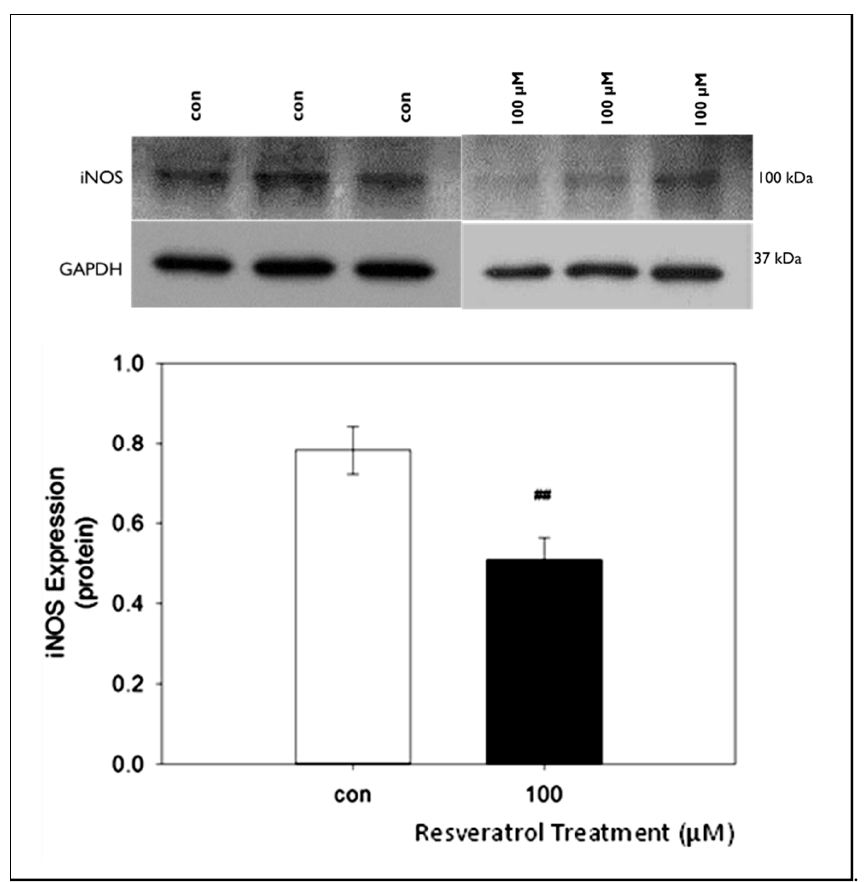
Figure 5. The e ff ects of 100 µ M resveratrol concentration on iNOS expression in GTM-3 cells. Figure Figure 5. The effects of 100 µM resveratrol concentration on iNOS expression in GTM-3 cells. Figure shows mean ± SEM ( n = 3). ## = p < 0.05 compared to control. shows mean ± SEM ( n = 3). ## = p < 0.05 compared to control. con — control. Quantification of western blot data yielded average protein values of 0.78 ± 0.06 and 0.51 ± 0.05